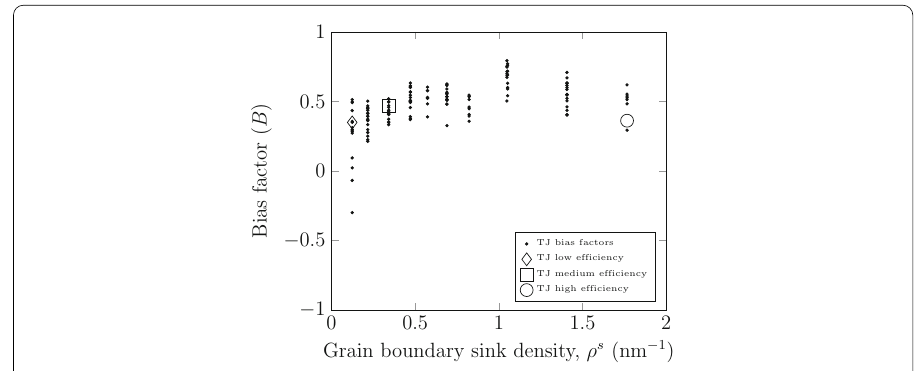
Fig. 6 Bias factor plotted against the sink density of GB “31”. Open symbols correspond to TJ regions with low, medium and high sink efficiencies